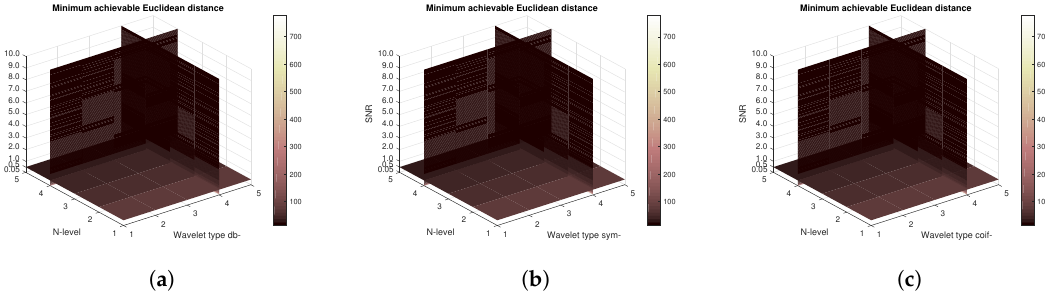
Figure 24. Mean achievable Euclidean distances of all EMG signal with use of three mother wavelet families—from left Daubechies ( a ), Symlet ( b ) and Coiflet ( c ).